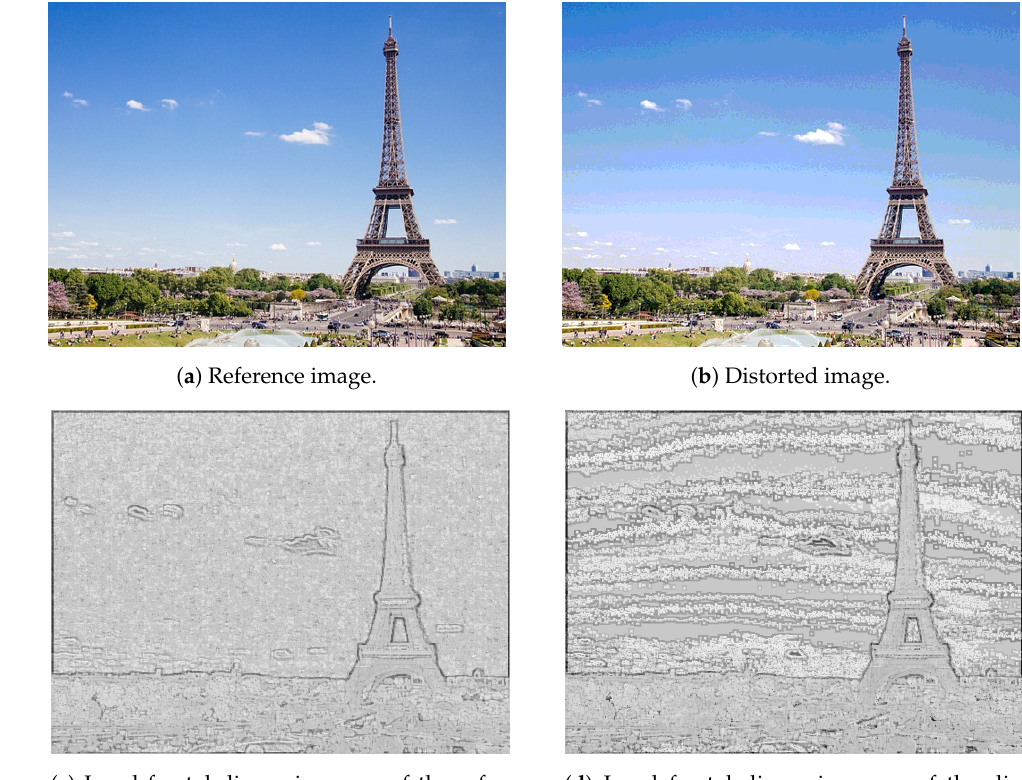
Figure 2. Illustration of local fractal dimension